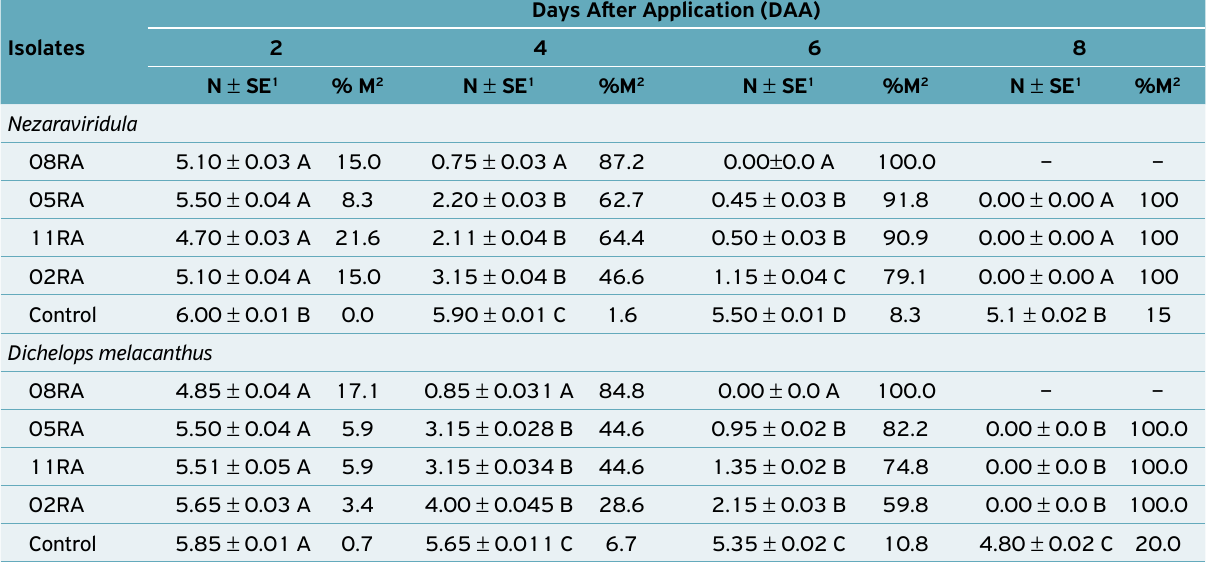
Table 1. Average number of live insects (N ± Standard Error (SE)) and cumulative mortality (%M) of N. viridula or D. melacanthus adults exposed to different isolates of M. anisopliae in the